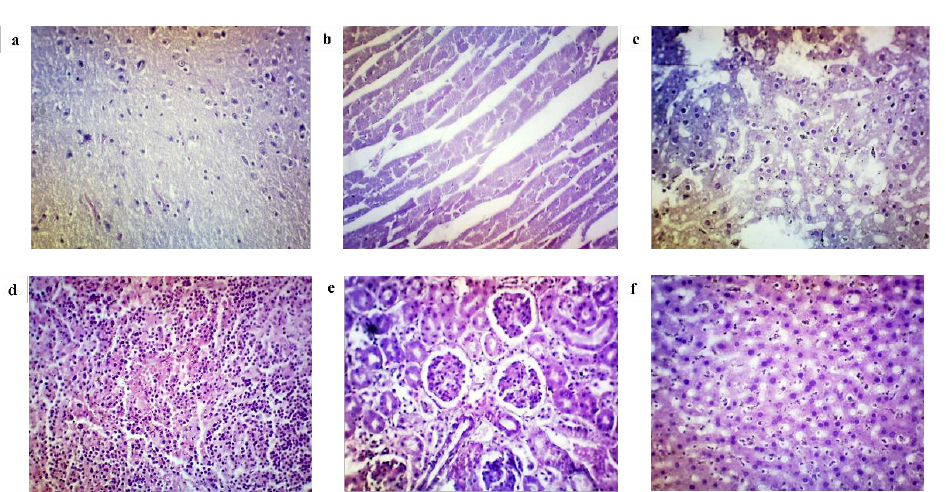
Figure 7. Histopathology changes in the brain ( a ), heart ( b ), lung ( c ), spleen ( d ), kidney ( e ), and liver ( f ) of unimmunised mice in Group B after ETEC challenge (H and E, ×400). ( a ) Section from the brain shows gliosis and necrotic areas. ( b ) Section from the heart shows mild degeneration of myocytes with mild interstitial oedema. ( c ) Section from a lung shows extensive lymphocytic infiltration, congestion, and oedema of the interstitium with focal alveoli oedema and type II pneumocytes hyperplasia. ( d ) Section from the spleen shows moderate focal parenchymal congestion with enlarged germinal centres, focal white pulp disintegration and apoptosis. ( e ) Section from a kidney shows mild degeneration of tubules, congestion, and moderate inflammation of the interstitium. ( f ) Section from the liver shows mild degeneration of hepatocytes and Kupfer cell hyperplasia, moderate portal inflammation and bile duct hyperplasia, and severe sinusoidal congestion. Table 1. Histopathological findings of mice after ETEC challenge studies. Relative organ weight of BALB/c mice after immunisation and ETEC H10407 challenge